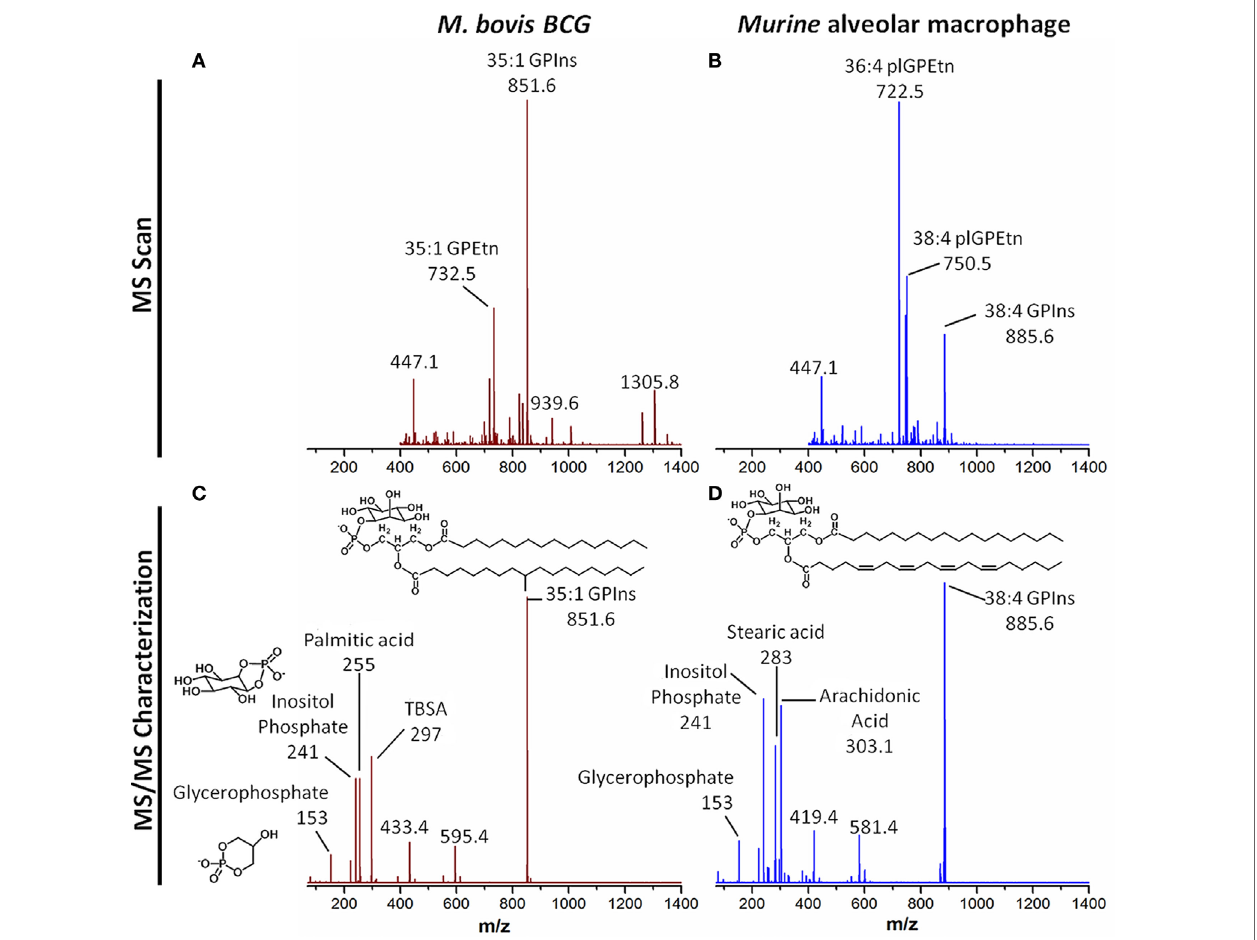
FiGURe 2 | Resolving host and microbial (polar) lipid molecular species by mass spectrometry (MS), a tool for probing host–pathogen interactions. With advances in technologies particularly MS, it is now possible to profile, characterize, and quantify lipids from both microbes and macrophages as well as other host cells and tissues. (A) Single stage MS scan to generate the “lipid profiles” of M. bovis BCG, an experimental surrogate for M. tuberculosis . (B) Single stage MS scan to generate the “lipid profiles” of murine alveolar macrophages. (C) MS/MS of the major phosphatidylinositol from M. bovis BCG, with mass-to-charge ratio ( m / z ) of 851.6. Collision-induced dissociation reveals the ion contains palmitic acid ( m / z 255) and TBSA ( m / z 297), as well as the phosphoinositol ( m / z 241) and glycerophosphate ( m / z 153) headgroups. This confirms the sum composition of fatty acyls to be 35:1 (35 carbons, 1 double bond). (D) MS/MS of the major phosphatidylinositol from murine alveolar macrophages, with m / z of 885.6. Collision-induced dissociation reveals the ion contains stearic acid ( m / z 283) and arachidonic acid ( m / z 303.1), as well as the phosphoinositol ( m / z 241) and glycerophosphate ( m / z 153) headgroups. This confirms the sum composite of fatty acyls to be 38:4 (38 carbons, 4 double bonds). The bioanalytical tool can be applied to probe the dynamic changes in levels of thousands of species of lipids from both the host and the pathogens, leading to the identification of novel pathways involved in infection and inflammation. Abbreviations: GPEtn,